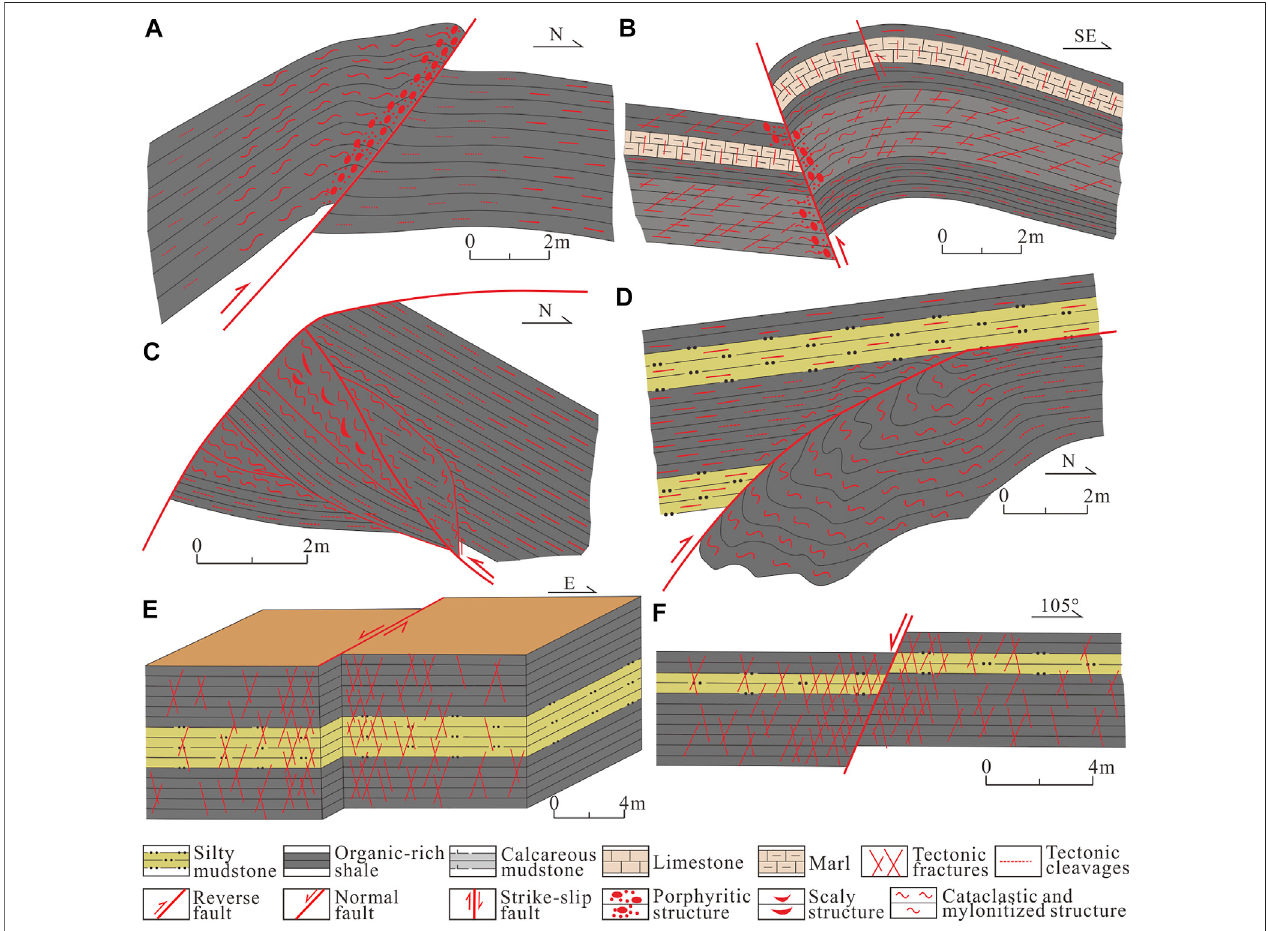
FIGURE 7| Distribution schematic diagrams ofshale deformation structures in fault structures. Notes: (A) a reverse faultin observation point G0810; (B) a reverse fault in observation point G0703; (C) a reverse fault in observation point G0707; (D) a reverse fault in observation point G0809; (E) a strike-slip fault in observation point G0811; (F) a normal fault in fracture measurement point